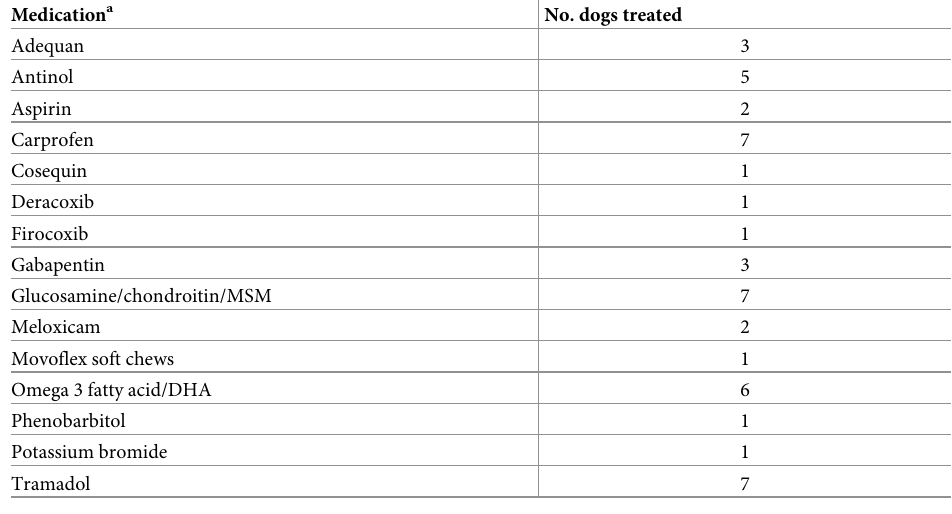
a Dosage size and frequency were